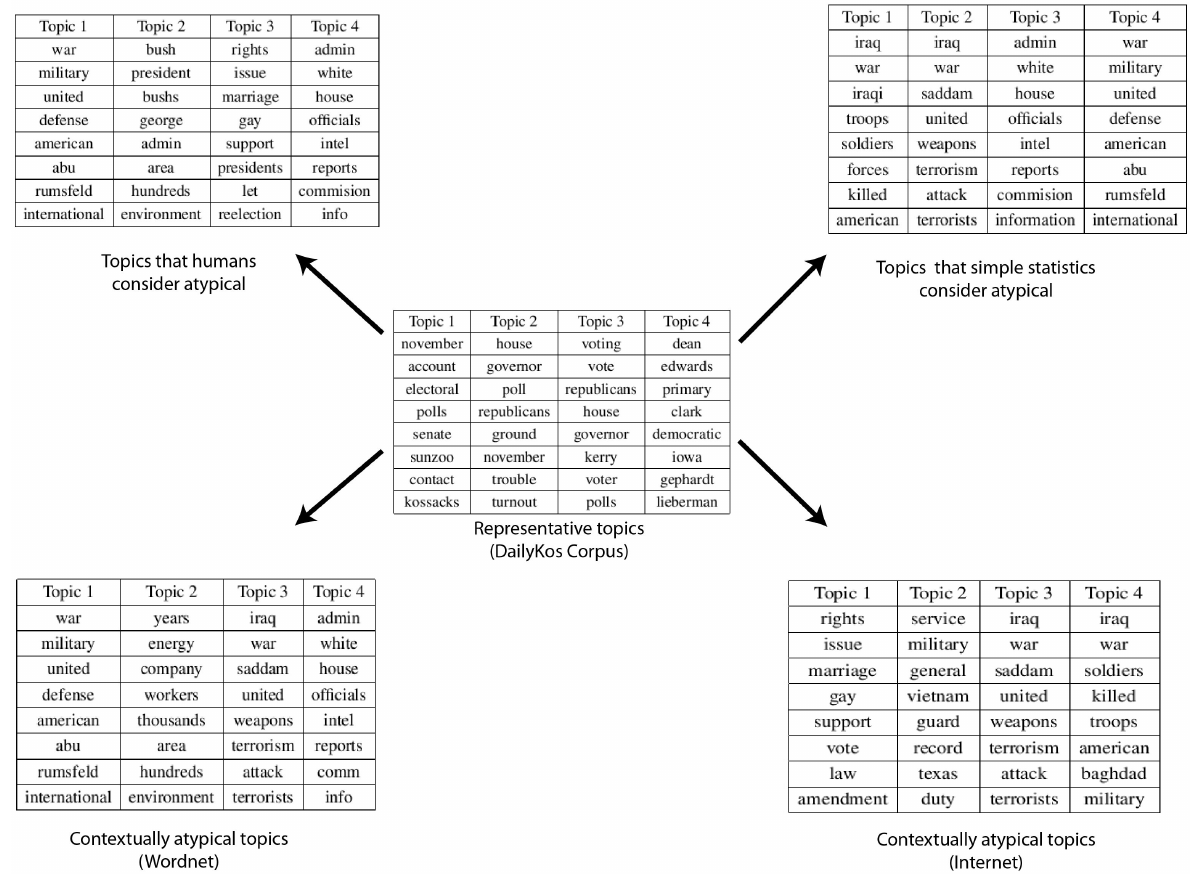
Figure 5. Results from the DailyKos dataset. Table in the center shows the most representative topics, table in the upper left corner shows the human adjudged anomalies, table in the upper right corner shows the statistical anomalies and tables in the bottom show the final contextual anomalies based on WordNet (left) and Internet (right)